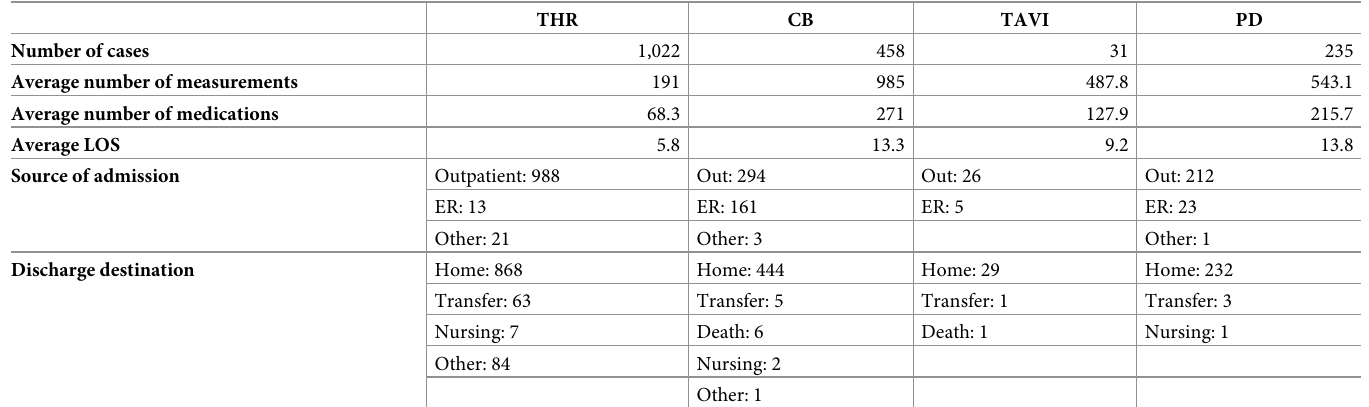
Table 7. Summary of the datasets.